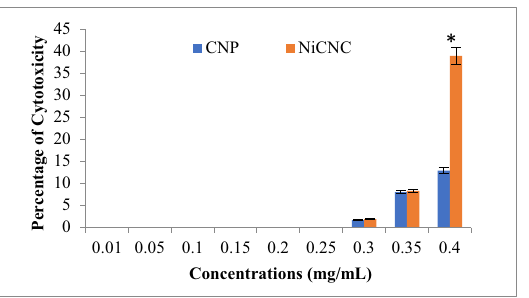
Figure 8. Comparison of cytotoxicity of CNPs and NiCNC on mammalian ACHN cells. Cellular toxicity was evaluated based on the percentage of cytotoxicity with different concentrations of CNPs and NiCNC (0.01– 0.4 mg/mL). Data are expressed as the mean ± standard deviation (n = 3). Asterisk mark indicates significantly different mean values (p ≤ 0.05) between CNPs and NiCNC